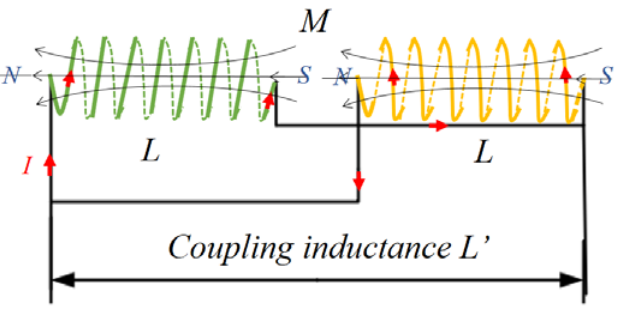
Figure 6. Inductance coupling model of parallel winding.